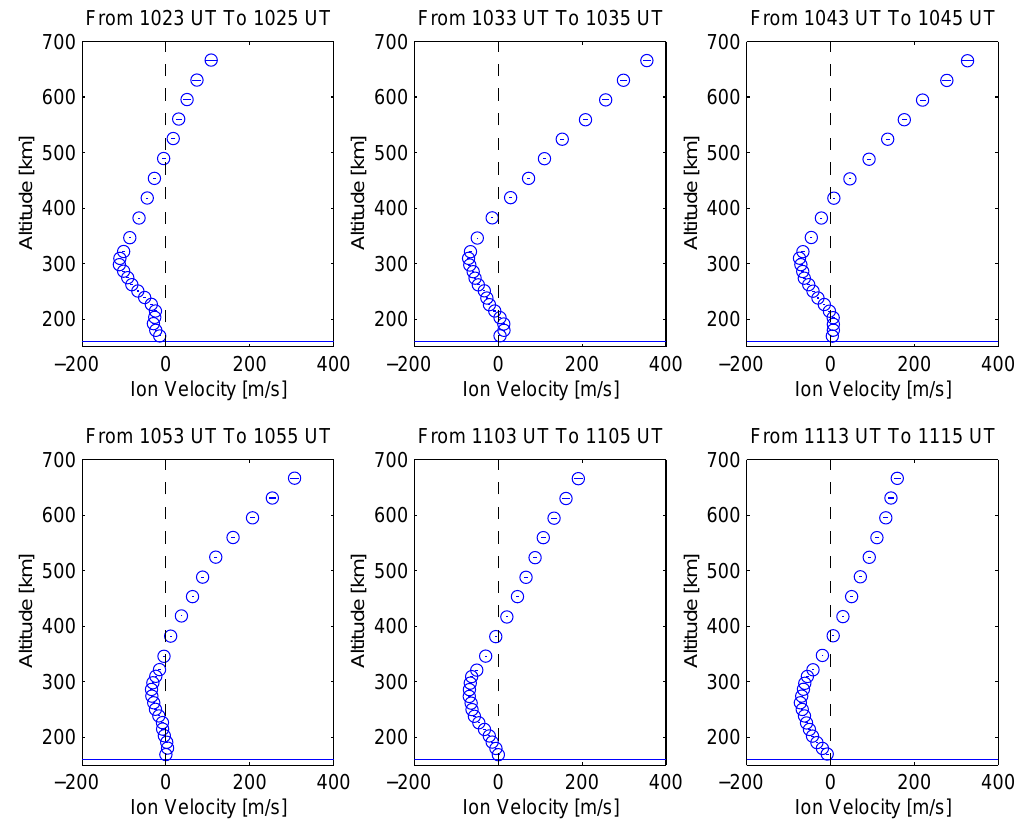
Fig. 2. Profiles of the field-aligned ion velocity observed by the ESR on 08 July 1999, from 10:23 until 11:15UT.